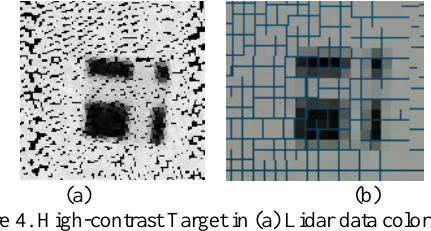
Figure 4. High-contrast Target in (a) Lidar data colorized by intensity (b) Kinect data colorized by